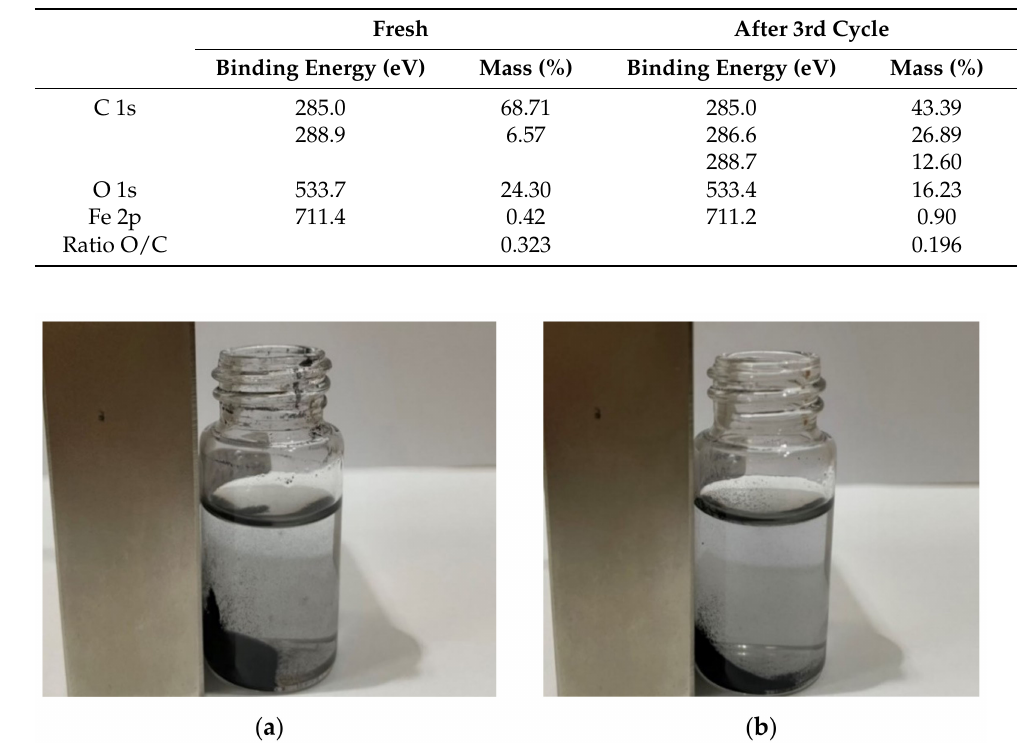
Table 5. XPS results of fresh and spent 0.5 FePt/AC catalysts after 3rd cycle.